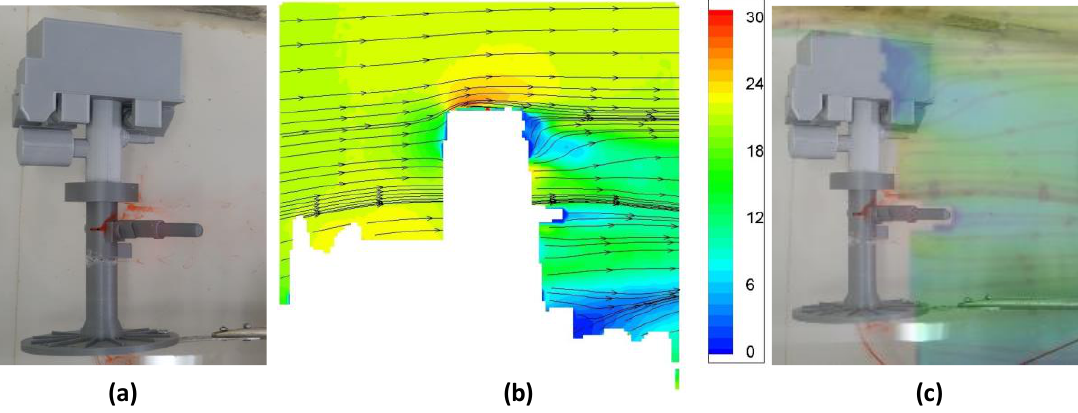
Figure 12. ( a ) Test carried out in a hydrodynamic towing tank at a slip angle of 270°; ( b ) wind tunnel test results; ( c ) overlap of the previous tests.